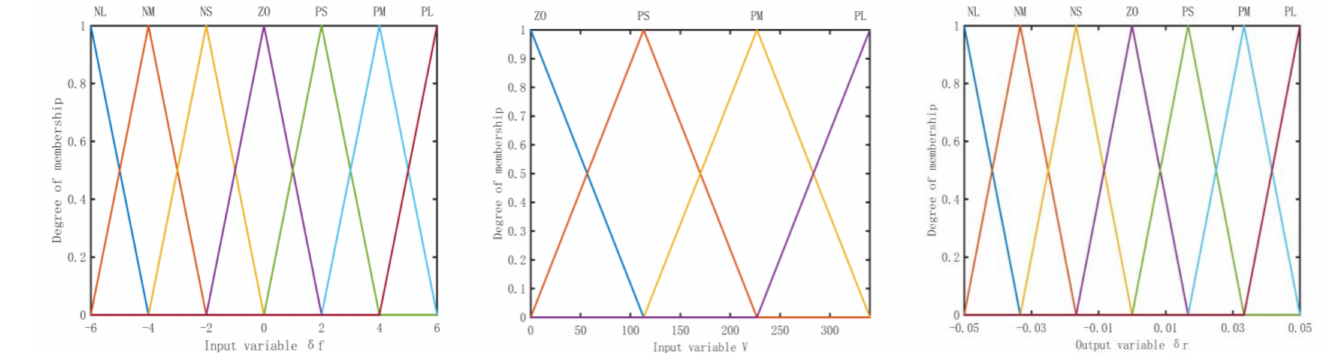
Figure 11. Membership function of input variable δ f , V and output variable δ r .